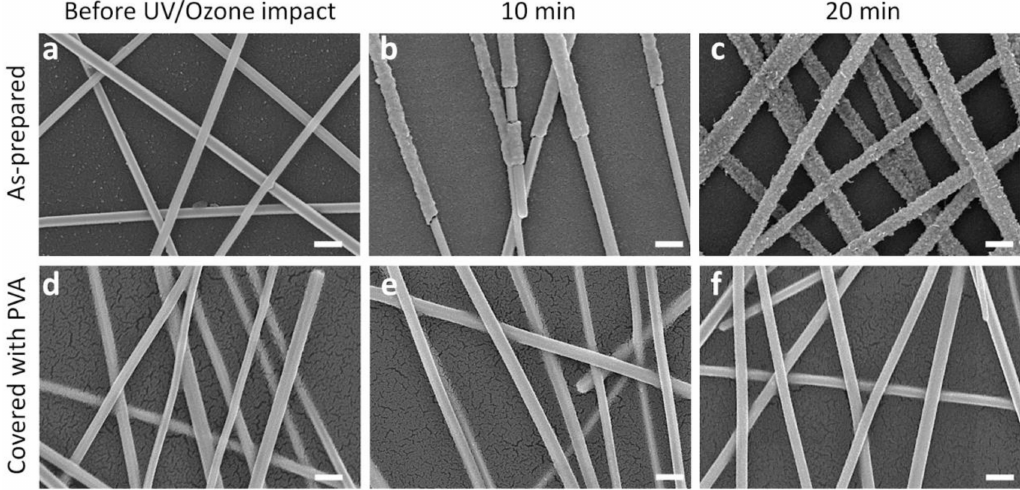
Figure 2. As prepared (non-covered) AgNW transparent conductive coating ( a ) before, and after UV / ozone treatment for ( b ) 10 and ( c ) 20 min. AgNW transparent conductive coating covered with poly-vinyl alcohol protective layer ( d ) before, and after UV / ozone treatment for ( e ) 10 and ( f ) 20 min. All scale bars correspond to 200 nm.